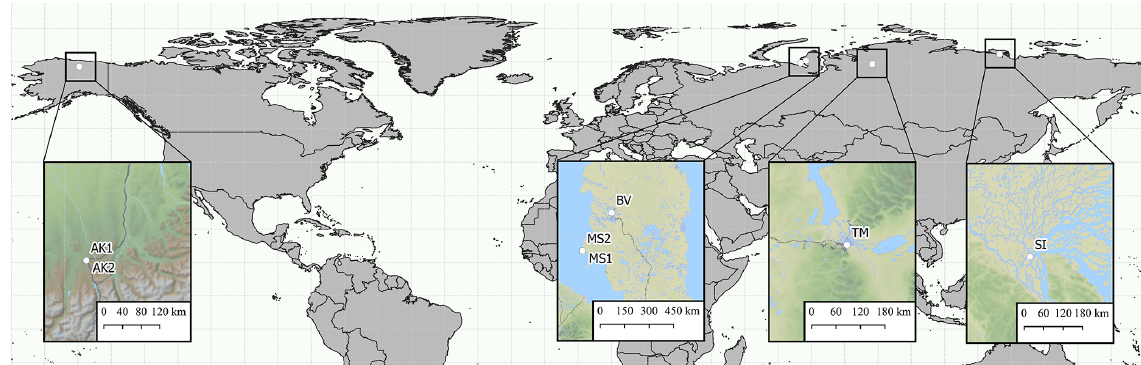
Figure 1. Location map of soil sampling test